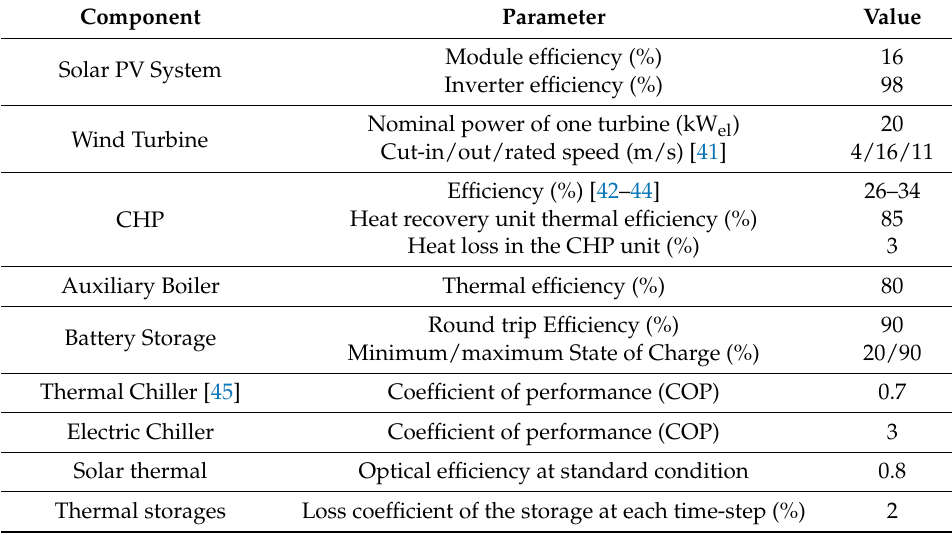
Table 3. Technical specification of each